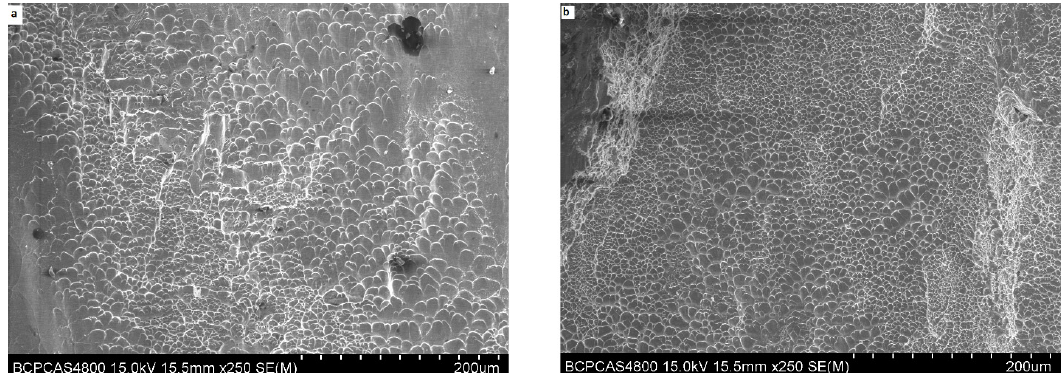
Figure 12. SEM images of the fracture surfaces of the NSSS. ( a ) Quasi-static loading and ( b ) dynamic loading (2500 s − 1